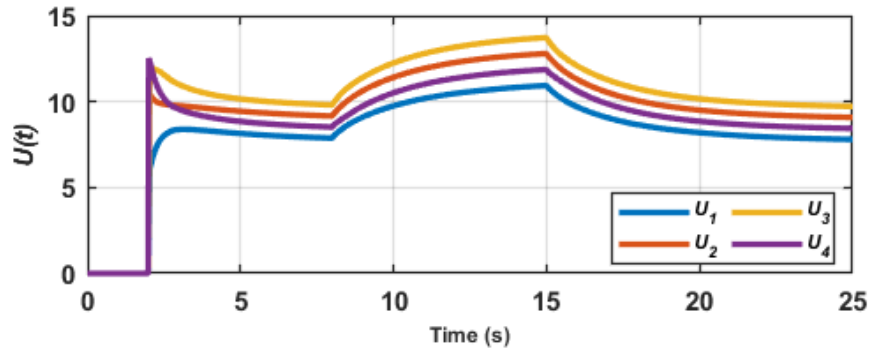
Figure 12. Output of proposed distributed secondary